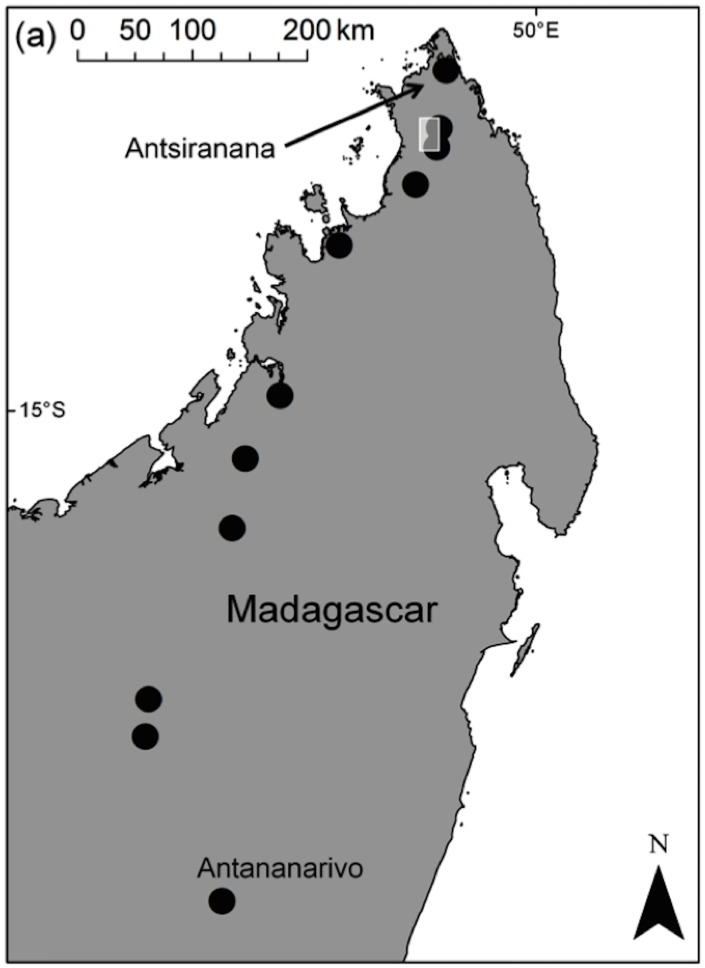
Urban towns in central and northern Madagascar where interviews were conducted.The shaded rectangle shows the location of rural towns (in the vicinity of the Ankarana National Park) where interviews were conducted but exact locations are not shown to protect respondent anonymity. Figure originally published in Reuter et al. 2015 [27].